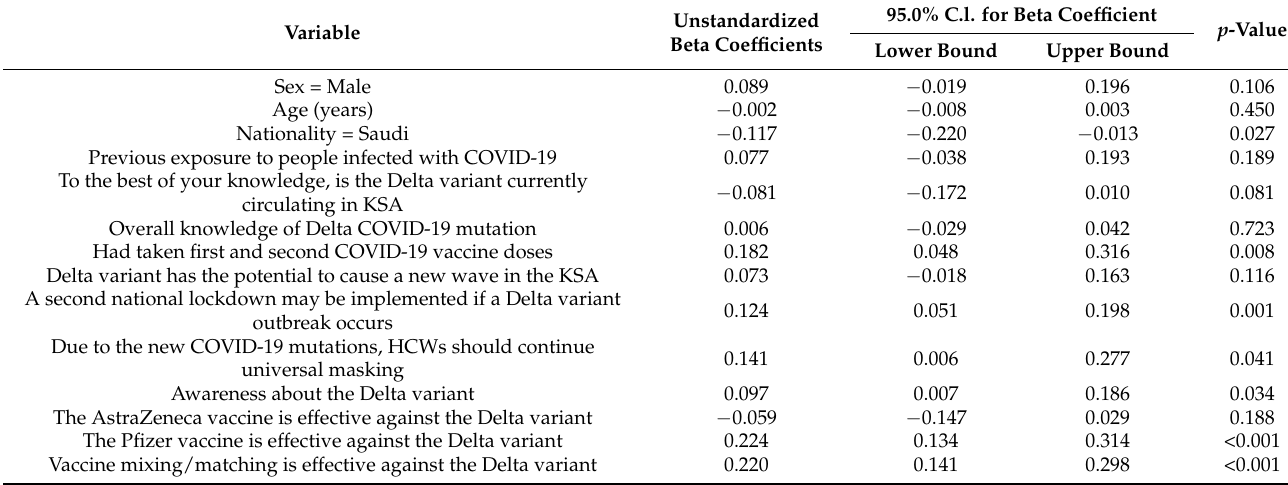
Table 8. Multivariate linear regression analysis of the respondent’s willingness to receive a COVID-19 vaccine booster